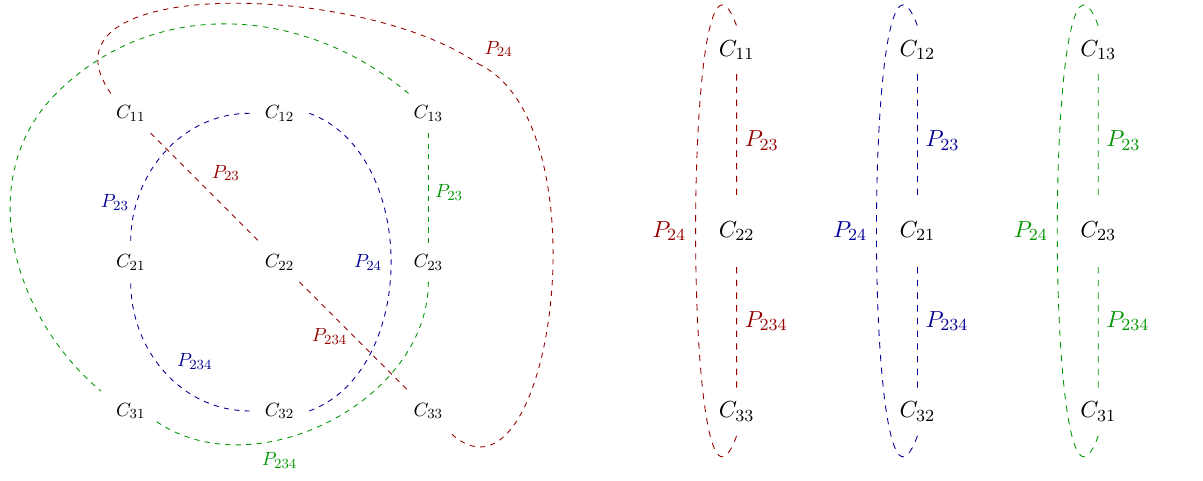
Fig. 2 Equivalent pictorial representation of the orbits as in Fig. 1